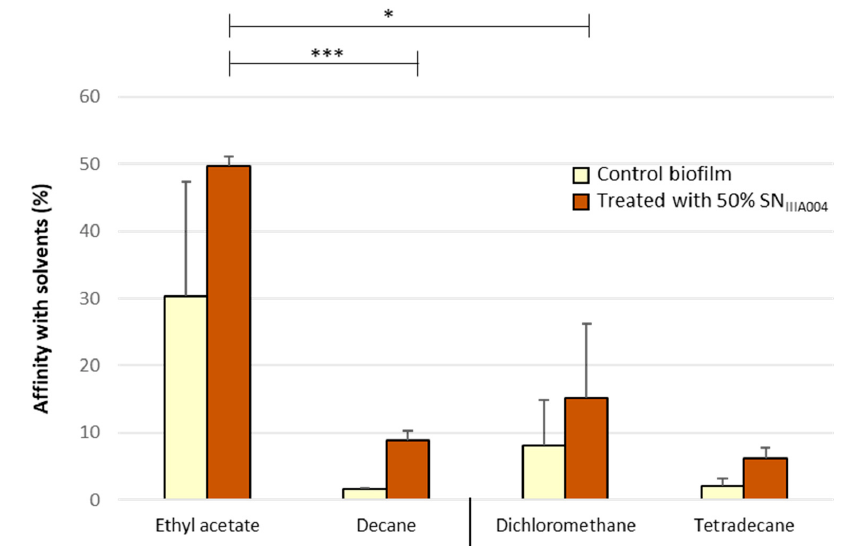
Figure 4. Percentage affinity of Roseovarius sp. VA014 cells to the four solvents used in the Microbial Adhesion To Solvents (MATS) method. Roseovarius sp. VA014 cells were pretreated with SN IIIA004 or Zobell broth (control). Two couples of solvents were used: ethyl acetate (monopolar basic) / decane (apolar) and dichloromethane (monopolar acidic) / tetradecane (apolar). Percentage affinities are mean values (± SD) of six experiments obtained from at least two independent treatments. Affinity di ff erences are indicated by * ( p < 0.05) or *** ( p <